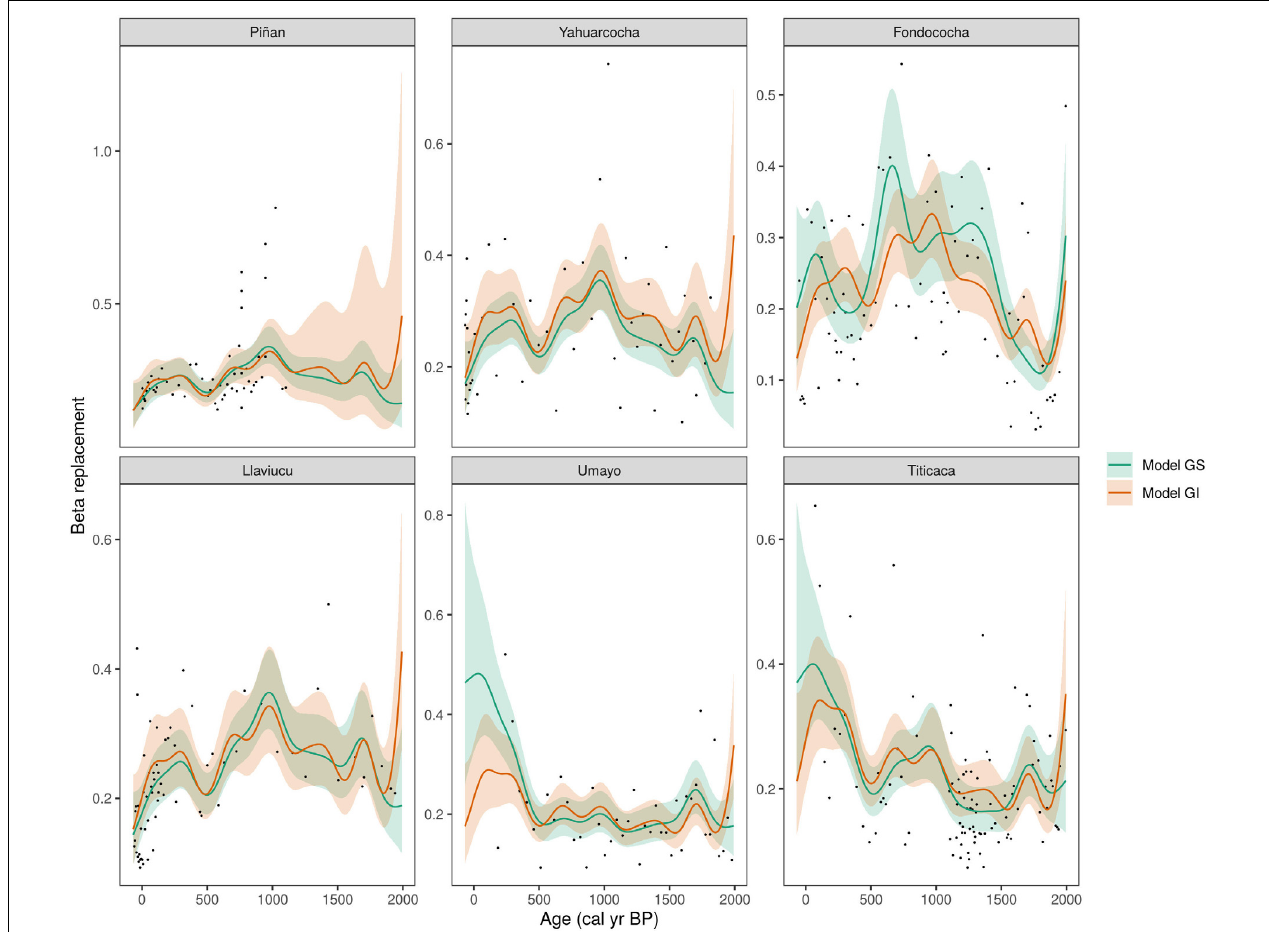
FIGURE 4 | Temporal trends of Hierarchical GAM-fitted beta replacement for the six Andean lakes investigated in this study (arranged by increased latitude). Model GS (green line) indicates a global curve and inter-lake variation having similar smoothness. Model GI (orange line) indicates a global curve allowing for varied smoothness among lakes. Points are original beta replacement values. Ribbons indicate ± 2 standard errors around the mean (green and orange lines for GS and GI models